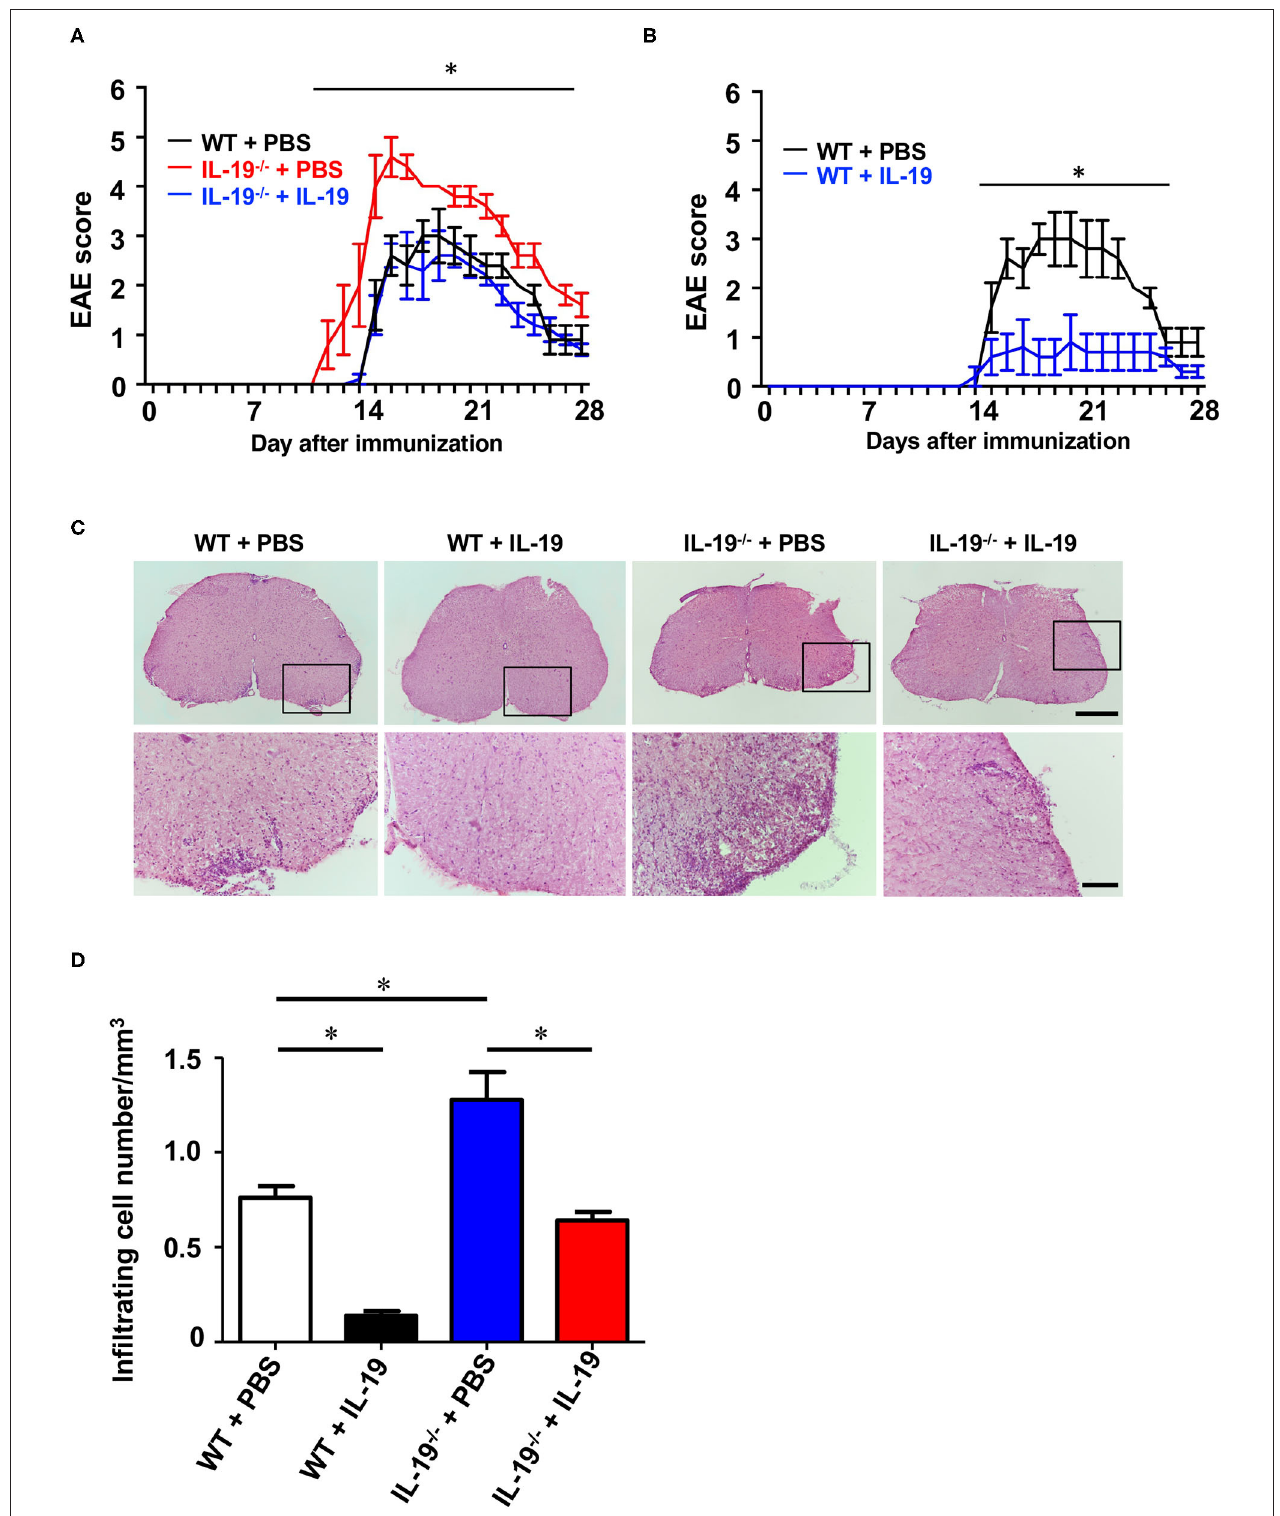
FIGURE 6 | Treatment with recombinant IL-19 alleviates EAE. (A) EAE clinical score. WT + PBS (black): WT EAE mice treated with PBS; IL-19 − / − + PBS (red): IL-19 − / − EAE mic treated with PBS; IL-19 − / − + IL-19 (blue): IL-19 − / − EAE mice treated with IL-19. (B) EAE clinical score. WT + PBS (black), WT EAE micee